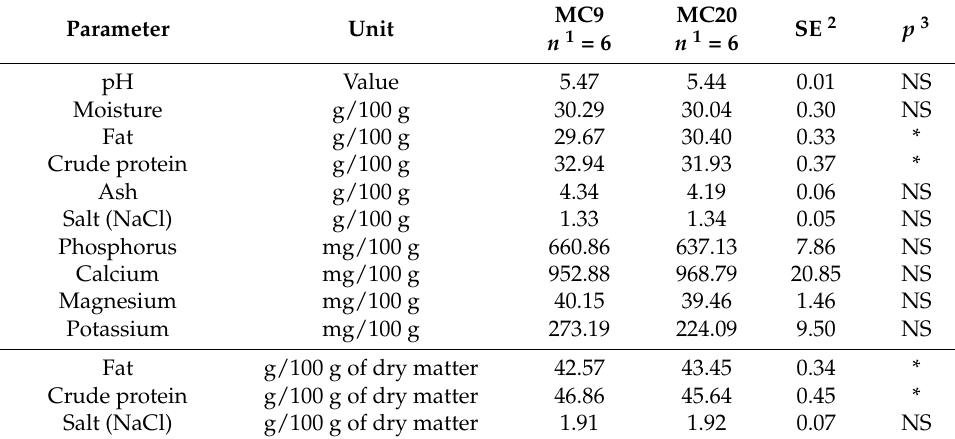
Table 2. Chemical composition of the outer zone of cheese wheels produced by milk kept at the farm at 9 ◦ C (MC9) or 20 ◦ C (MC20) (least-square-mean values).